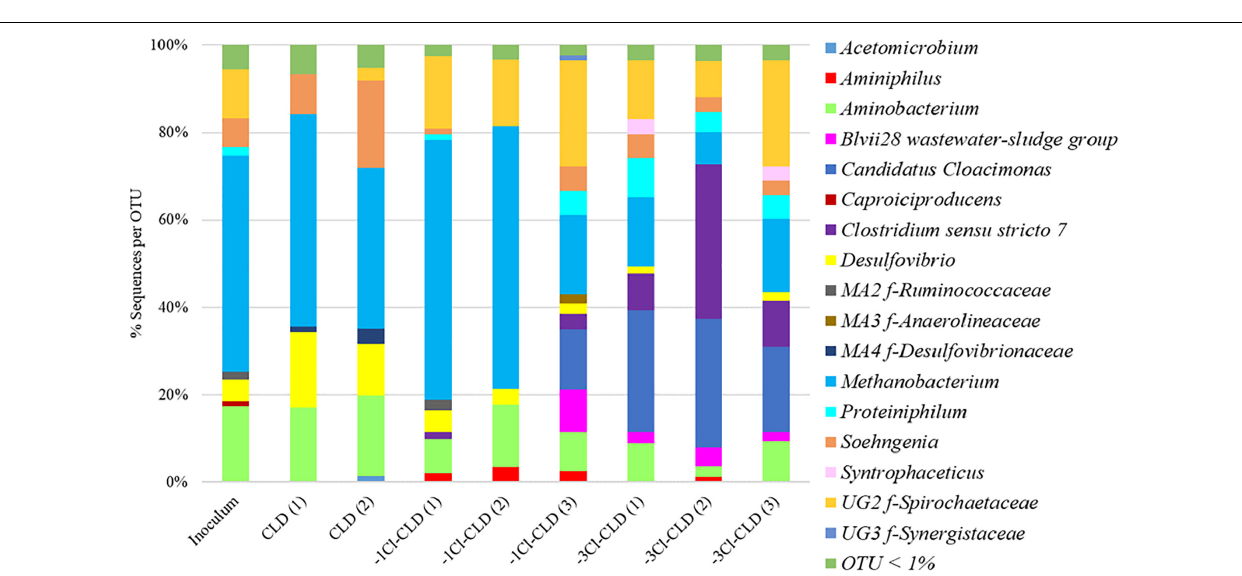
FIGURE 3 | Histogram of the bacterial and archaeal genus represented by > 1% of the sequences and identified to the genus level. Multi-affiliated (MA) and unknown genera (UG) are given with their associated family